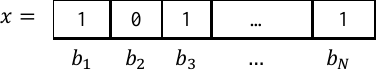
Figure 2. Flowchart of the PSO-MCS method.